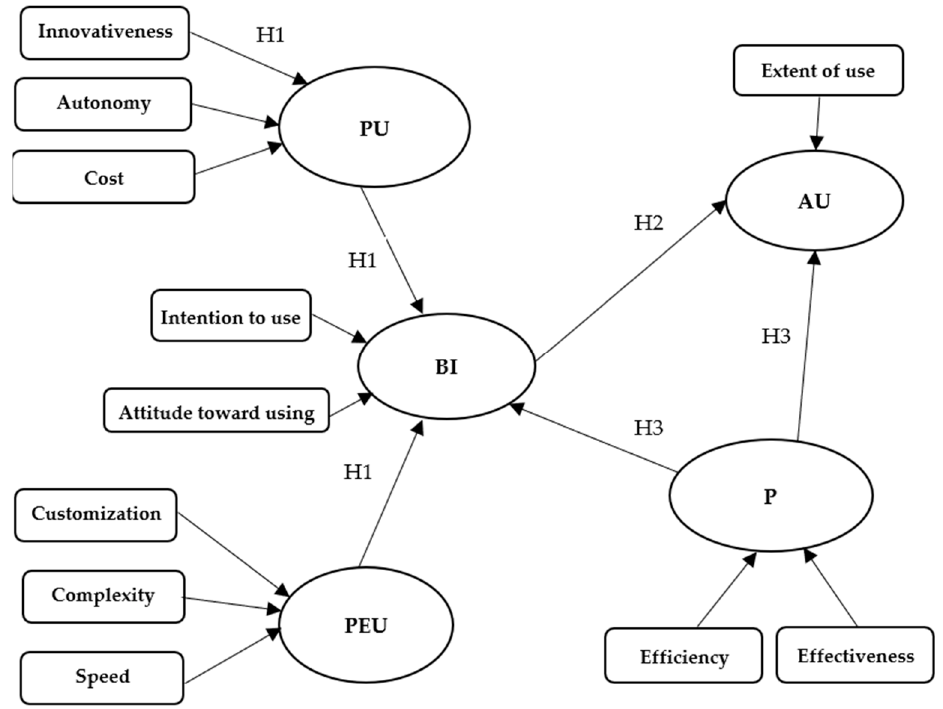
Figure 1. Conceptual model. Source: author’s design based on [10,11,66–72].